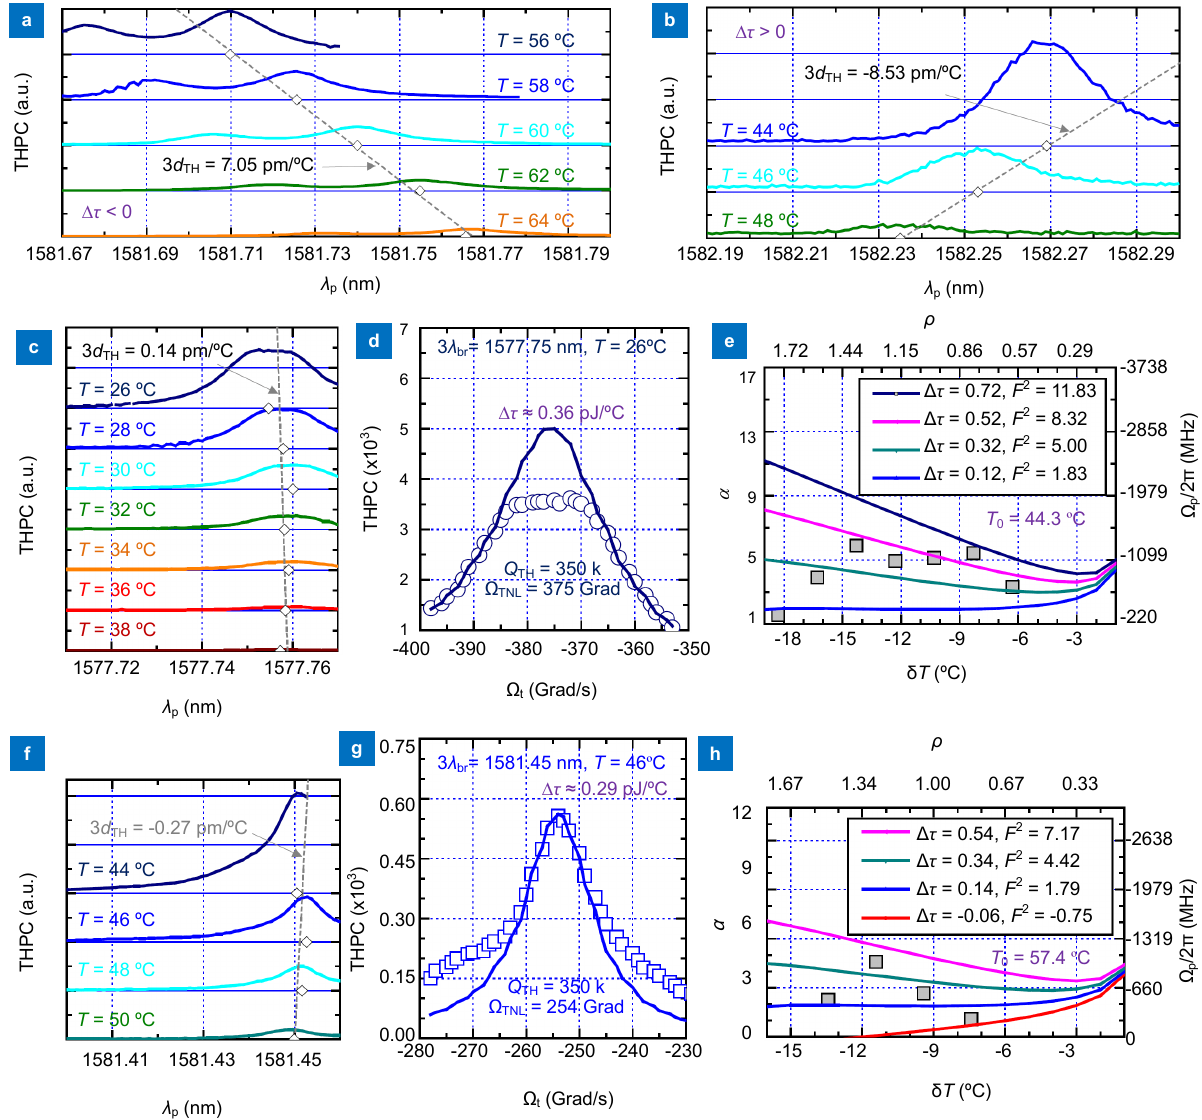
Fig. 5 | ( a ) Thermal mismatch ∆ τ < 0, with a TM pump generated a TM TH mode with a TDWS of 3 d TH = 7.05 pm/ºC. ( b ) Thermal mismatch ∆ τ > 0, with a TE pump generated a TE TH mode with 3 d TH = − 8.53 pm/ºC. ( c , f ) When thermal mismatch ∆ τ ≈ 0, with a TM pump generated TE TH mode with 3 d TH = 0.14 pm/ºC (c) as well as 3 d TH = − 0.27 pm/ºC (f). ( d , g ) The extracted Q-factor of TE TH modes by using the data in (c) at 26 ºC and in (f) at 46 ºC, with Eq. (4) is used to generate the fitted lines. ( e , h ) The temperature dependence of the athermal TH mode resonance fluctuation with fixed ∆ τ and F 2 for the TH modes shown in (c) and (f), with the measured values in gray squares. In (a – c) and (f), the measured wavelengths of the resonance peak of TH modes at different T are shown in open diamonds. The corresponding fitted TDWS of TH modes are shown in grey dashed